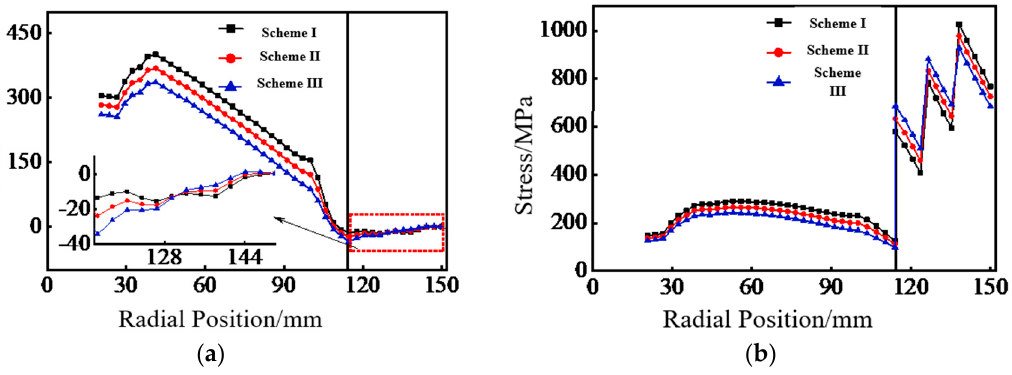
Figure 10. Stress curve of the flywheel at maximum speed. ( a ) Radial stress curve; ( b ) hoop stress curve.